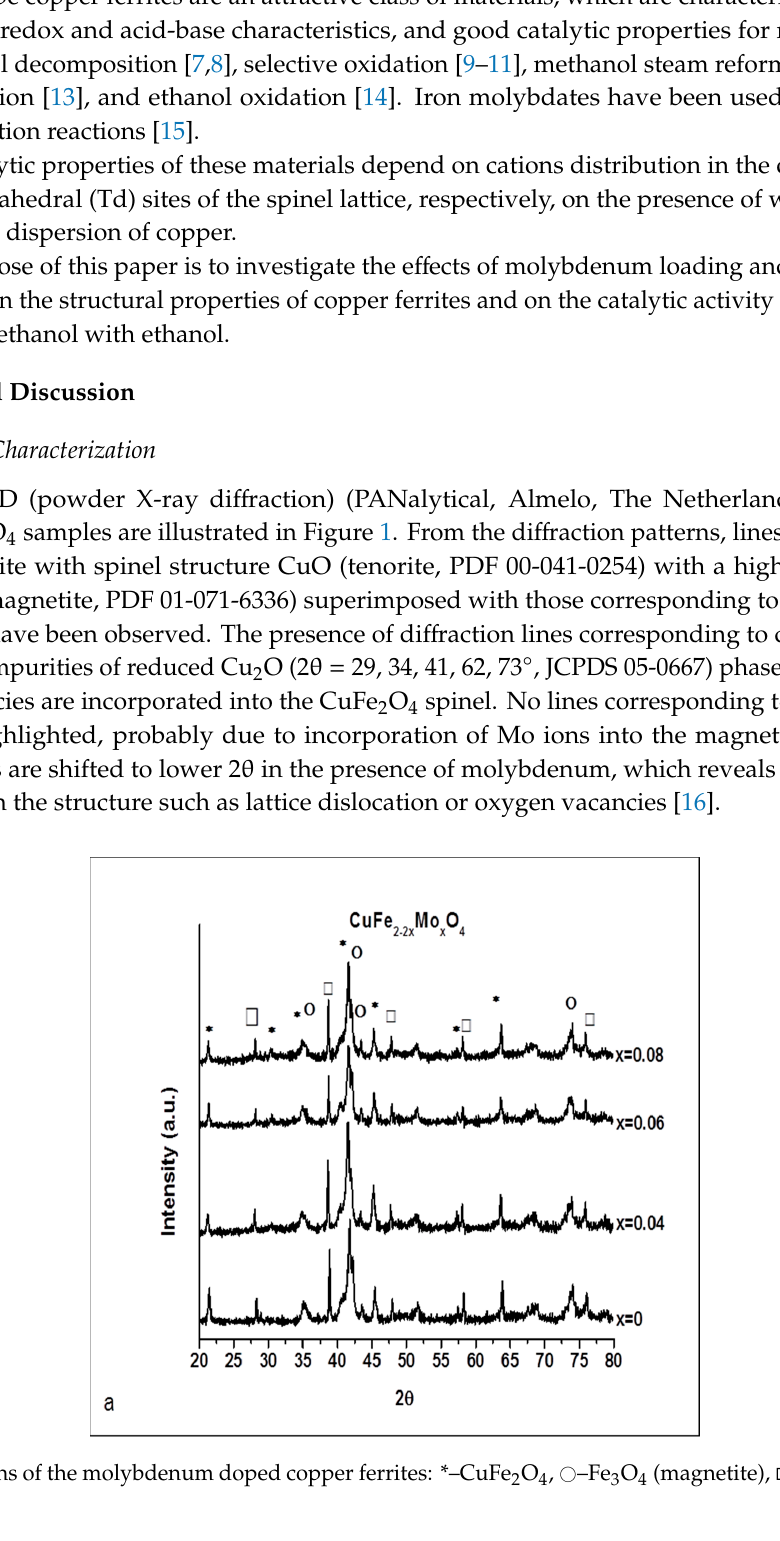
–Fe 3 O 4 (magnetite), (cid:3) –CuO (cid:35)